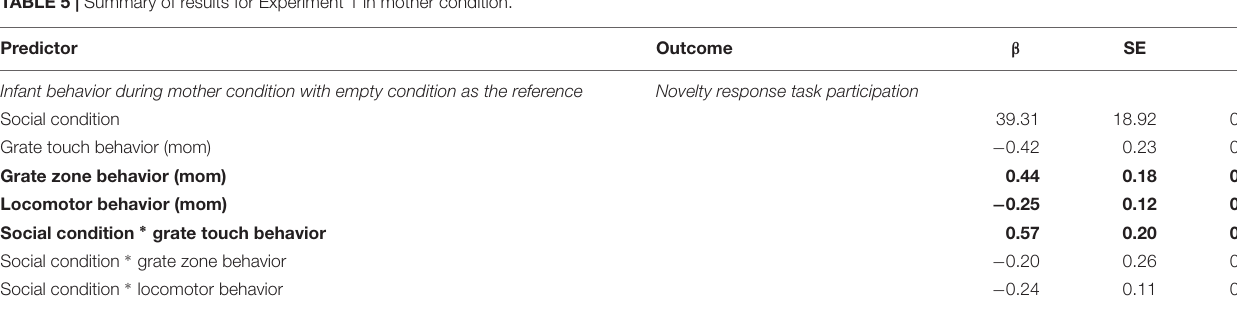
FIGURE 5 | Novelty response task participation ( N = 11) by infant behavior, specifically, locomotion. (A) Percent of task participation during difficult novelty response task trials plotted by infant locomotor behavior demonstrated by the average frequency of gridline crosses in a trial. (B) Interaction plot for the effects of test condition on the relationship between infant behavior and task participation. TABLE 5 | Summary of results for Experiment 1 in mother